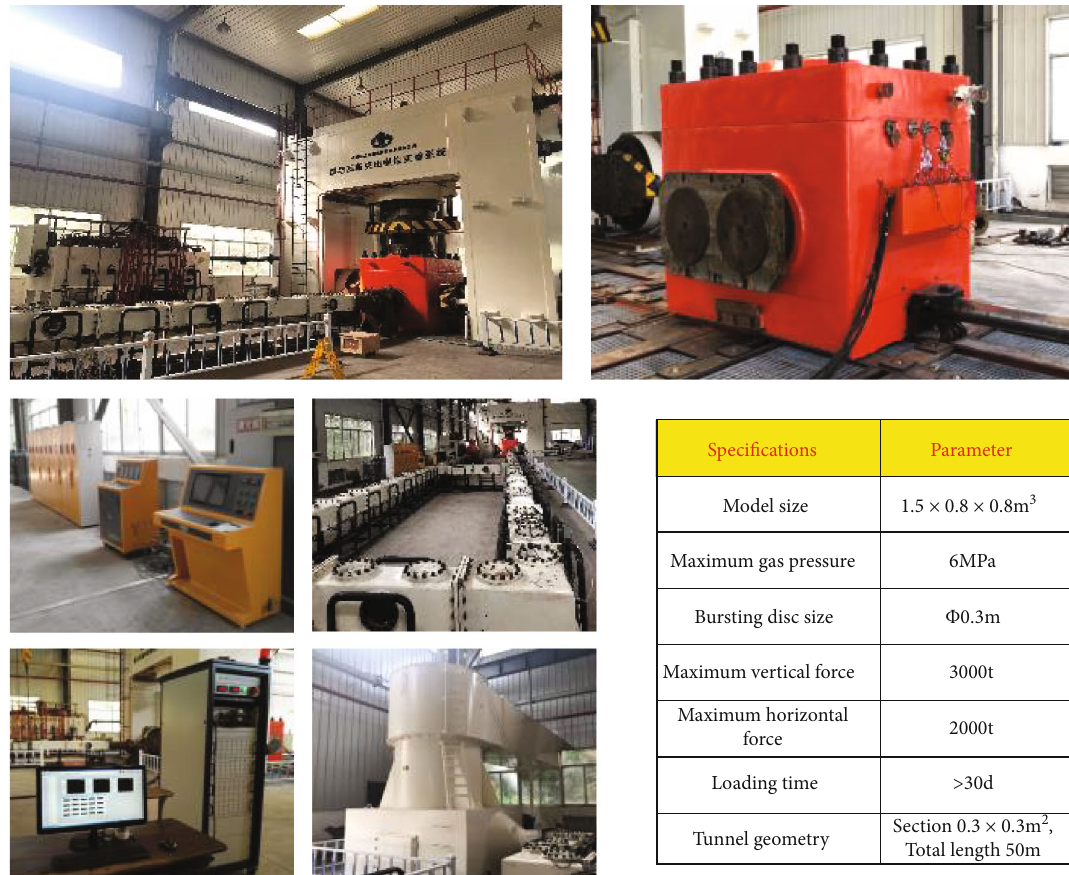
Figure 1: Coal and gas outburst simulation experiment